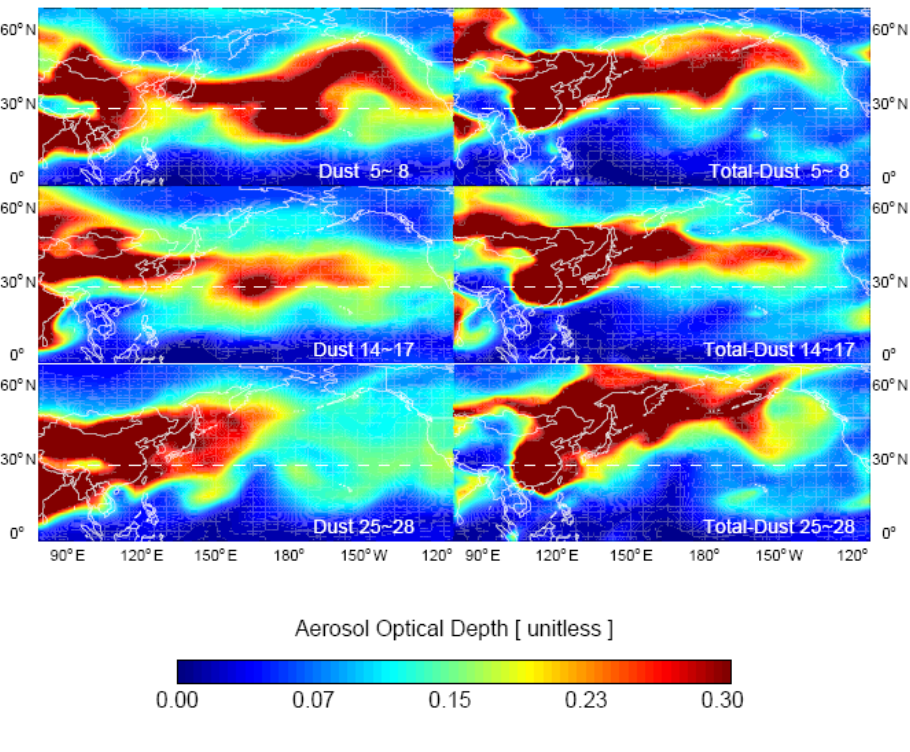
Fig. 4. AOD at 550nm of dust (left) and of all the other aerosols (right) simulated by GEOS-Chem over the Pacific during 5–8 (first row), 14–17 (second row), and 25–28 (third row) May 2003.